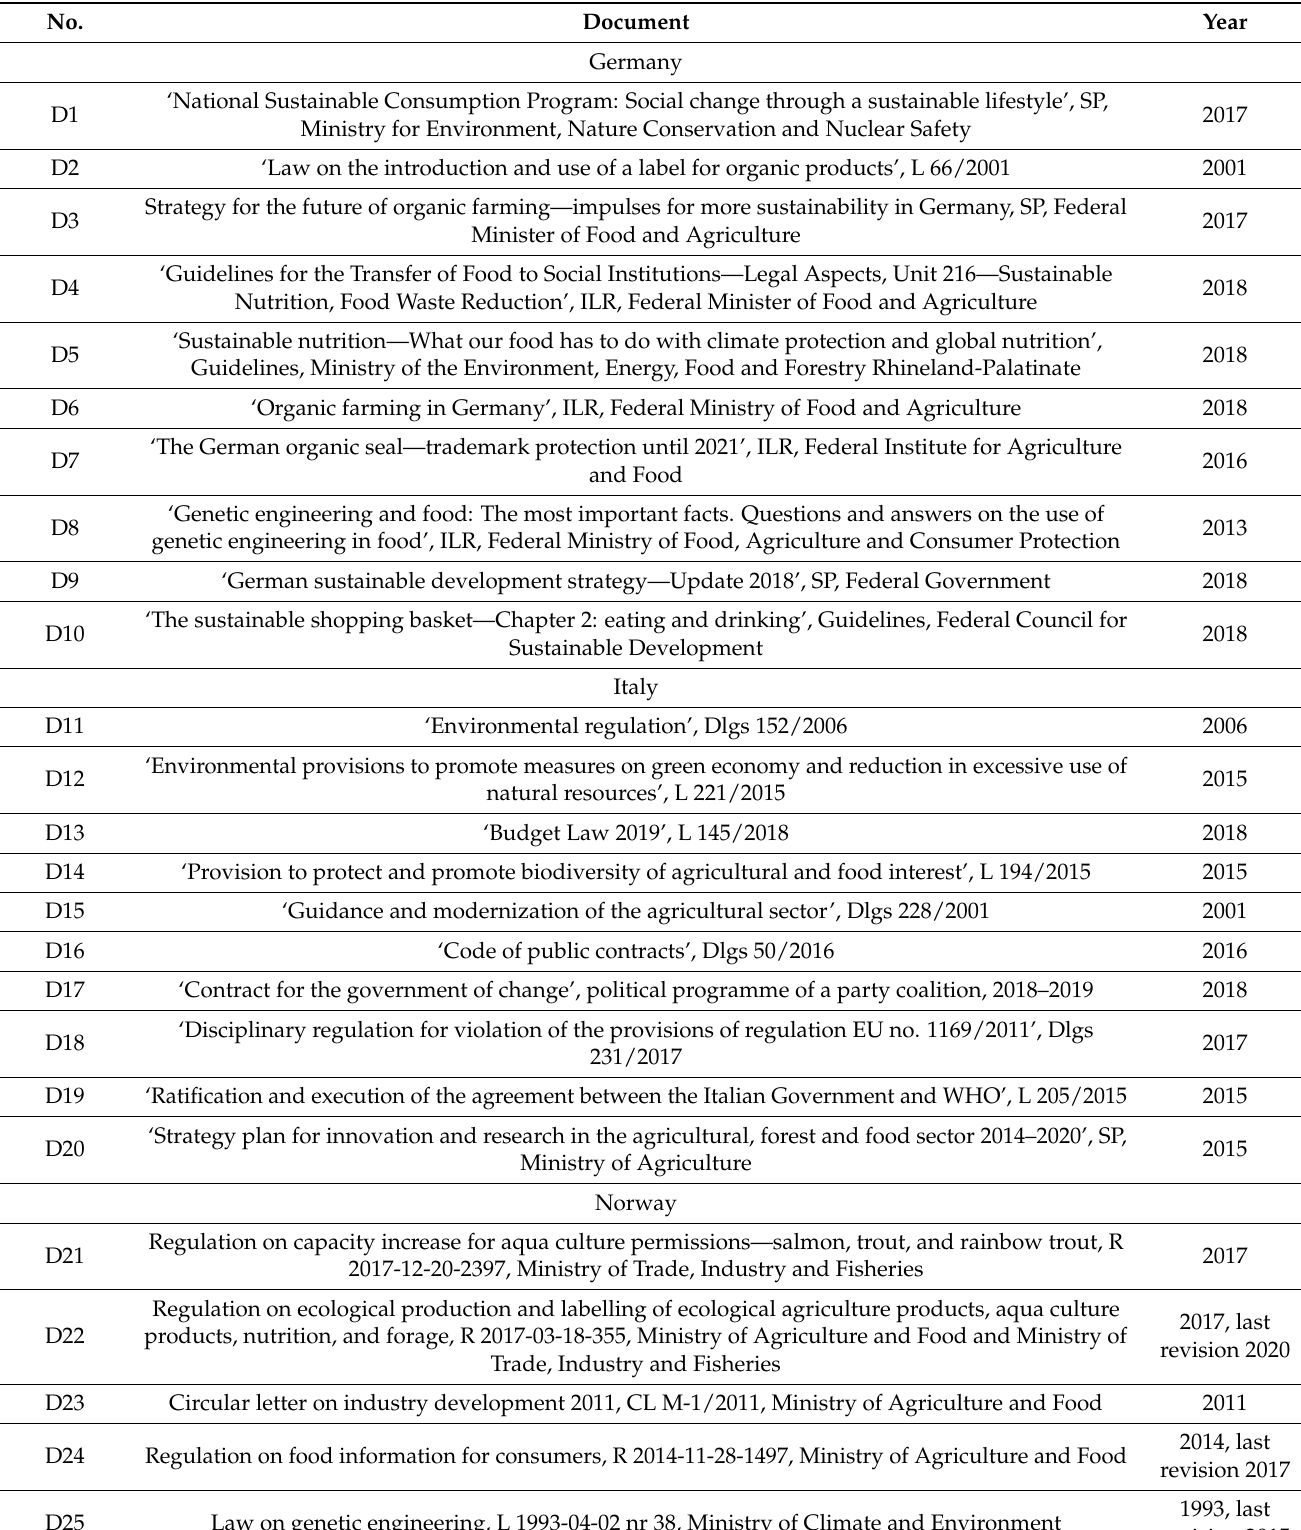
Table 1. Selected policy documents in each